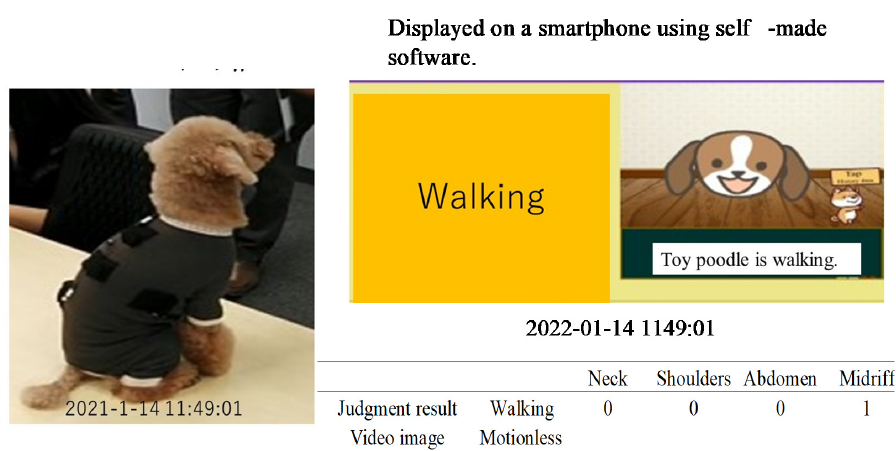
Figure 17. Examples of various matches between the judgment results and the video image.